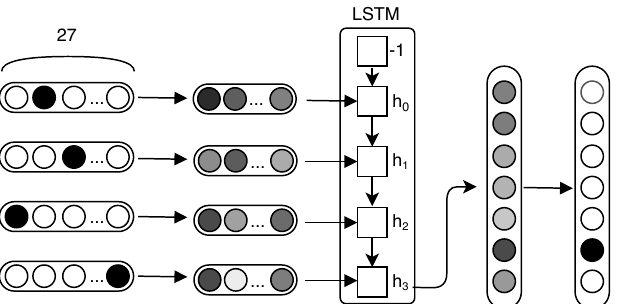
Figure 1: A diagram of the recurrent neural network: the input layer receives a string of four characters (stem + grammatical number), each coded as a one-hot vector of the length of the different characters used in the language (27). The in- put vectors are embedded and the embeddings are transferred to a hidden layer with 5–50 LSTM units. Output from the LSTM units ( h 3 ) is then transferred to an output layer with seven options, representing the seven suffixes in the lan- guage. Using a softmax function, the output is converted to a one-hot vector, representing the suffix the network selected for this input ‘glorot_uniform’ function (sampling from a uniform distribution in the range of [ − x , + x ], where x is a function of the size of the net-